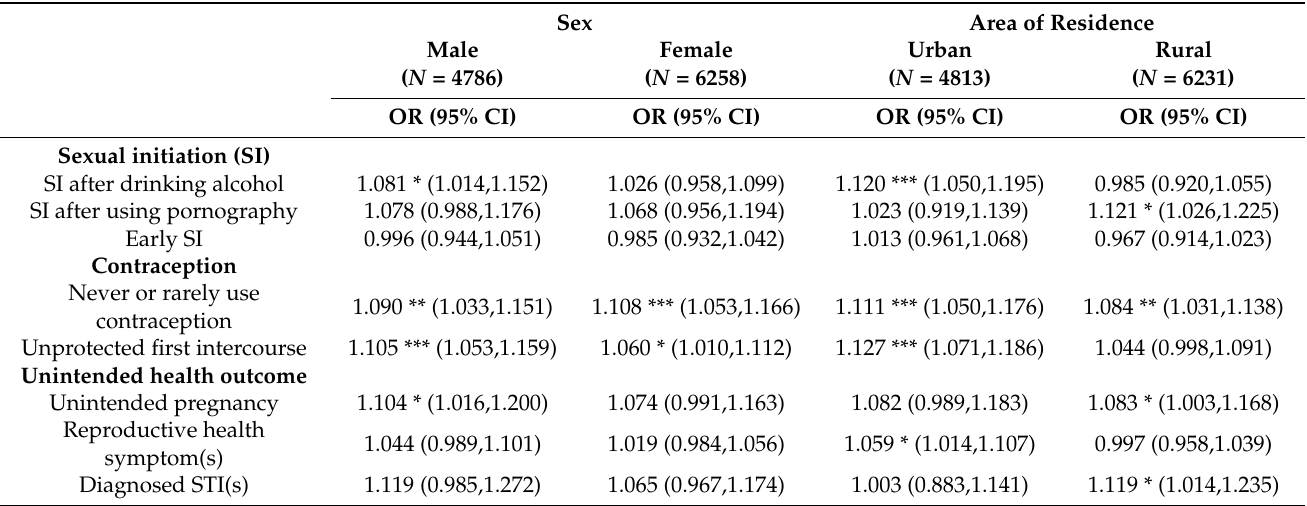
Table 4. Logistic regression of sibship size for sexual and reproductive health among Chinese young people, stratified by sex or area of